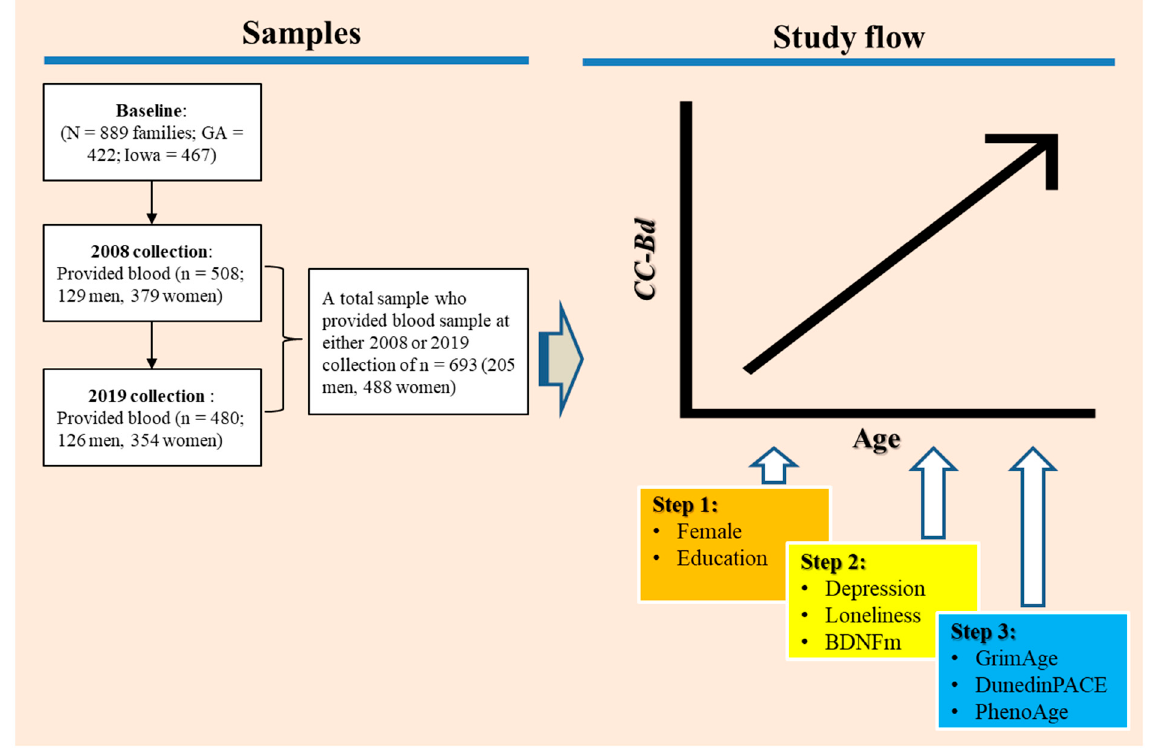
Figure 1. A graphical representation of the study fl ow .